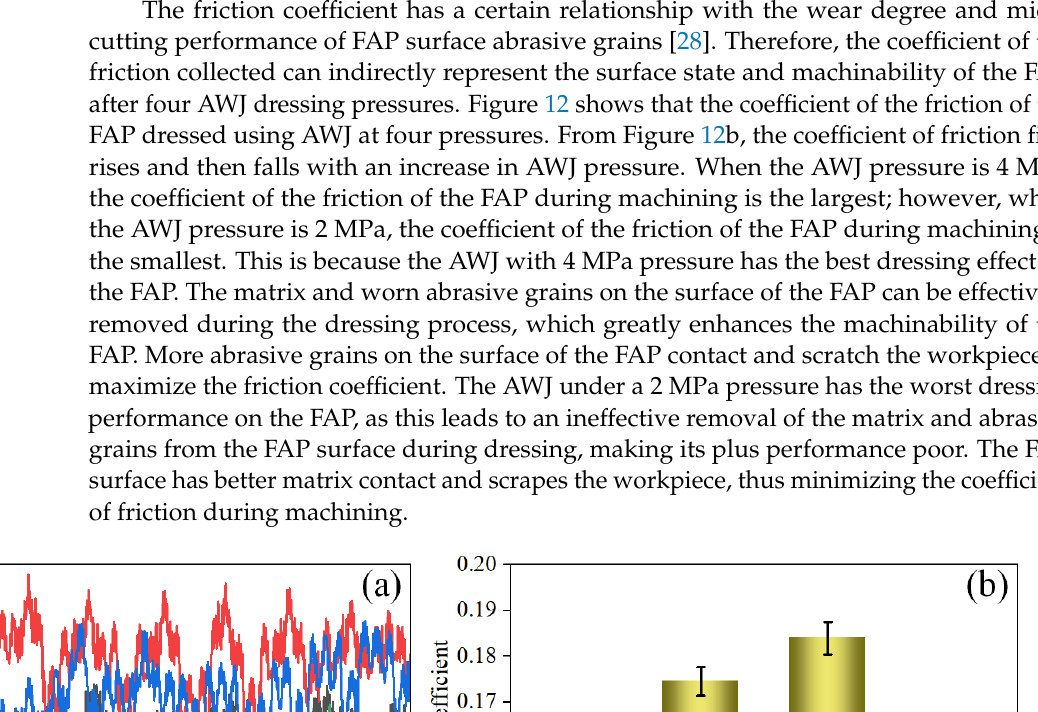
Figure 11. Ra of FAP and workpiece after dressing with AWJ under four pressures: ( a ) Ra of workpiece; ( b ) Ra of FAP.